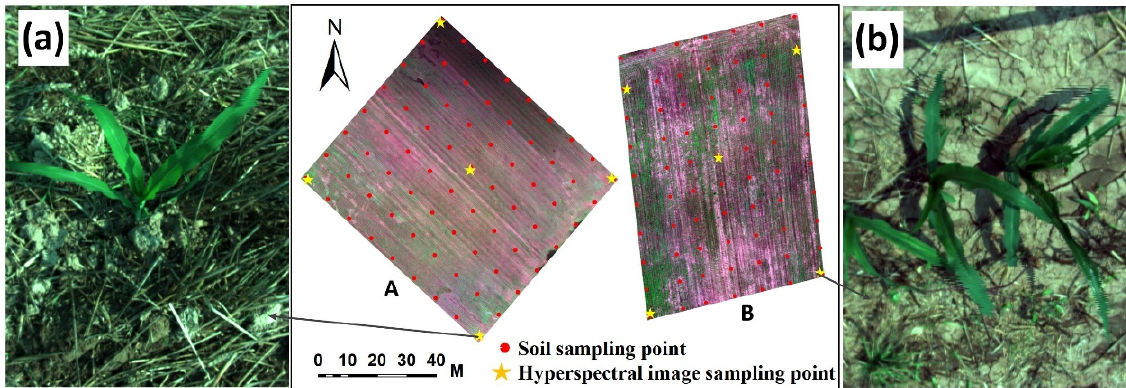
Figure 2. UAV images of the test areas (A, B) and ground hyperspectral images ( a , b ).